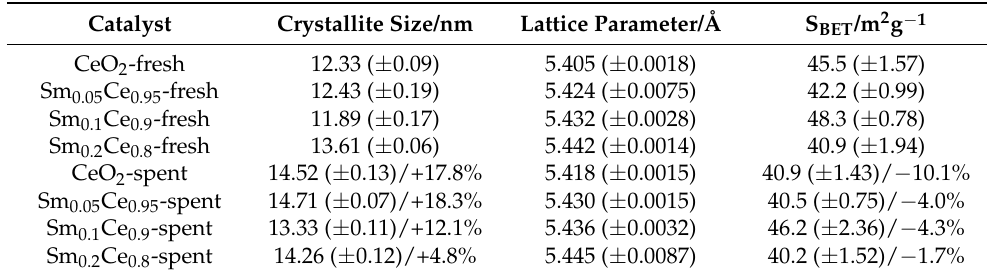
Table 1. Texture results of Sm-doped ceria fresh and spent catalysts (after five cycles). Percentages for spent catalysts indicate relative changes compared to fresh